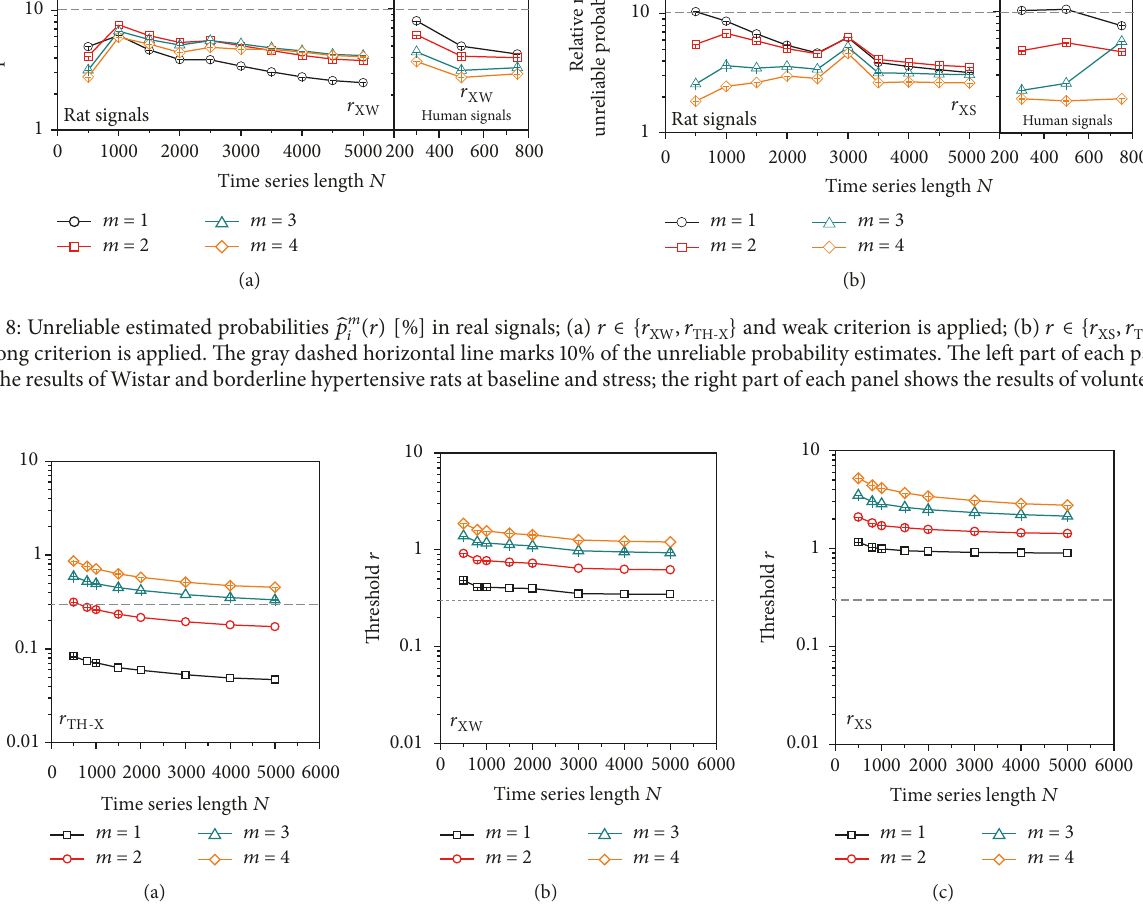
Figure 9: Calculated threshold values for artificial data, with signals X and Y both normally distributed. (a) Threshold for which XApEn gets maximal value (see (17)). (b) Threshold for which at least 95% of the probabilities satisfy weak criterion (see (19)). (c) Threshold for which at least 95% of the probabilities satisfy strong criterion (see (20)). The gray horizontal dashed line corresponds to 𝑟 = 0.3